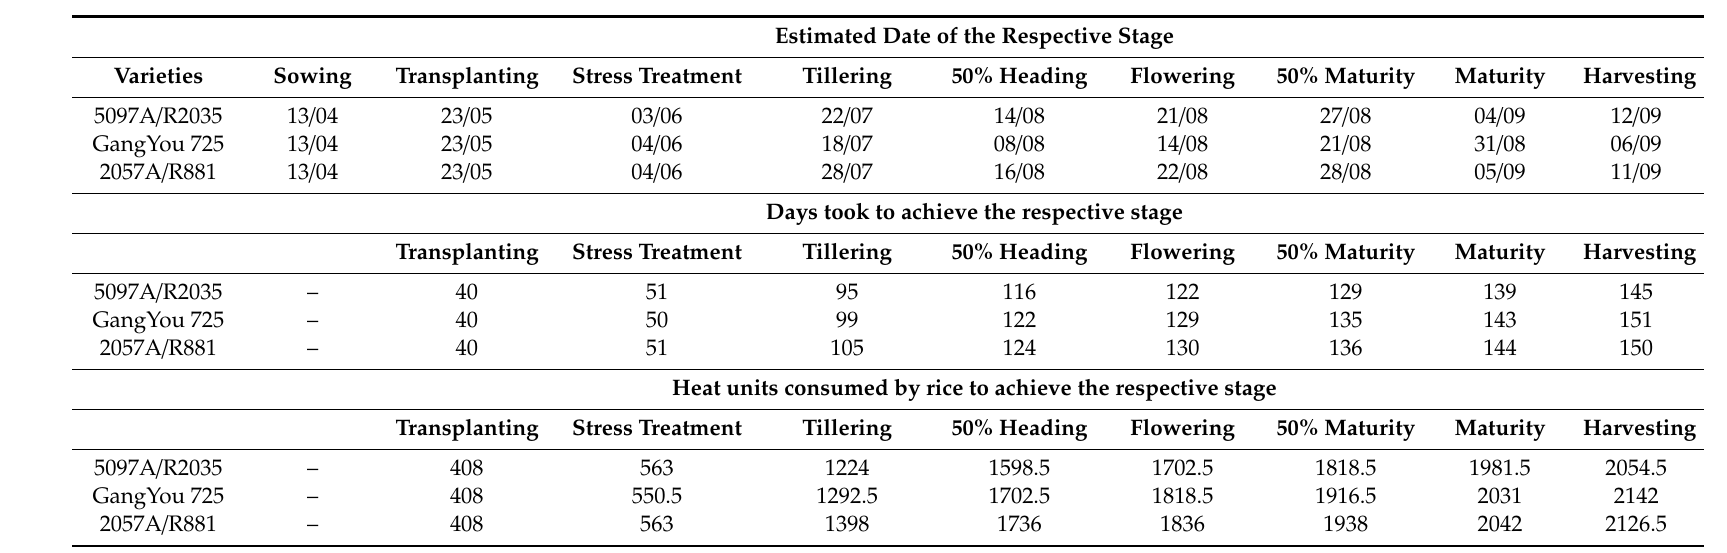
Table 4. Number of days and amount of heat units consumed by rice to achieve respective